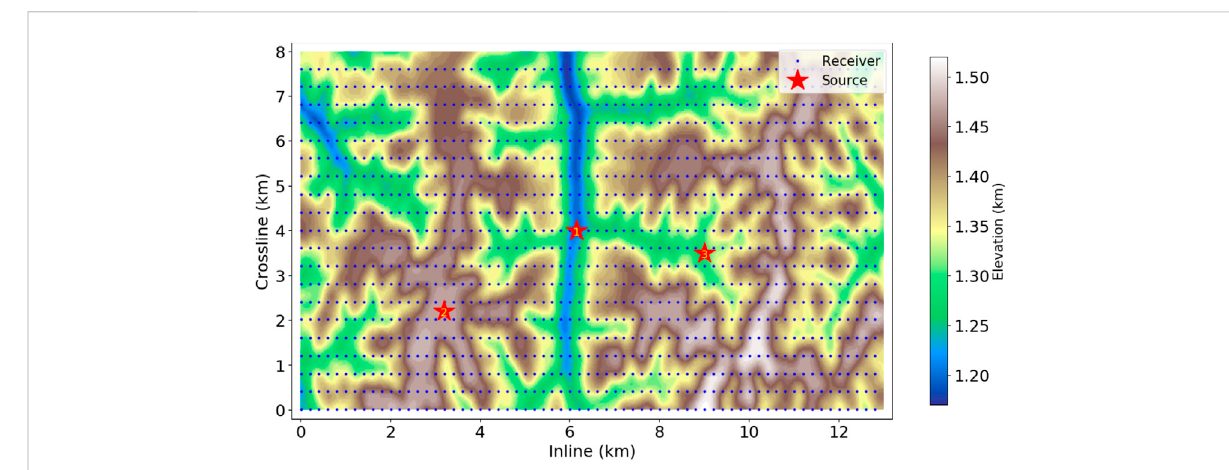
FIGURE 16 Source and receiver distributions of three observation systems for 3D wave fi eld models. Red stars denote the source locations of three experiments at the ditch (1), hill (2) and valley (3), and blue dots denote receivers.